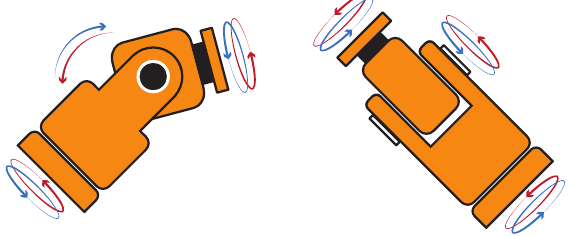
Figure 3. Spherical wrist mechanism for orientation of a robot manipulator.